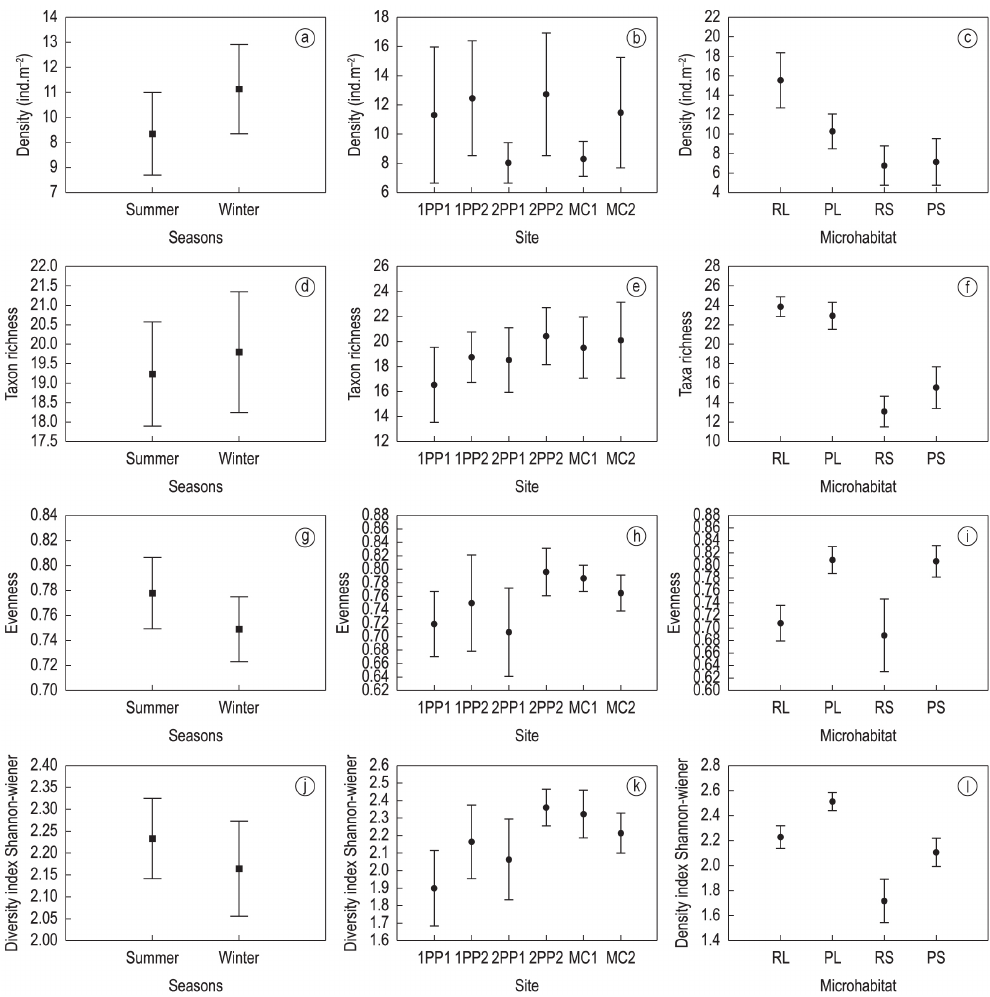
Figure 3. Mean density (a, b, c), richness (d, e, f), evenness (g, h, i) and diversity (j, k, l) of Chironomidae assem- blage per seasons, sites and microhabitats. 1PP1: stream 1 of Poço Preto site 1, 1PP2: stream 1 of Poço Preto site 2, 2PP1: stream 2 of Poço Preto site 1, 2PP2: stream 2 of Poço Preto site 2, MC1: stream Macuco site 1, MC2: stream Macuco site 2. FC: riffle litter, FR: pool litter; SC: riffle sediment, SR: pool sediment.